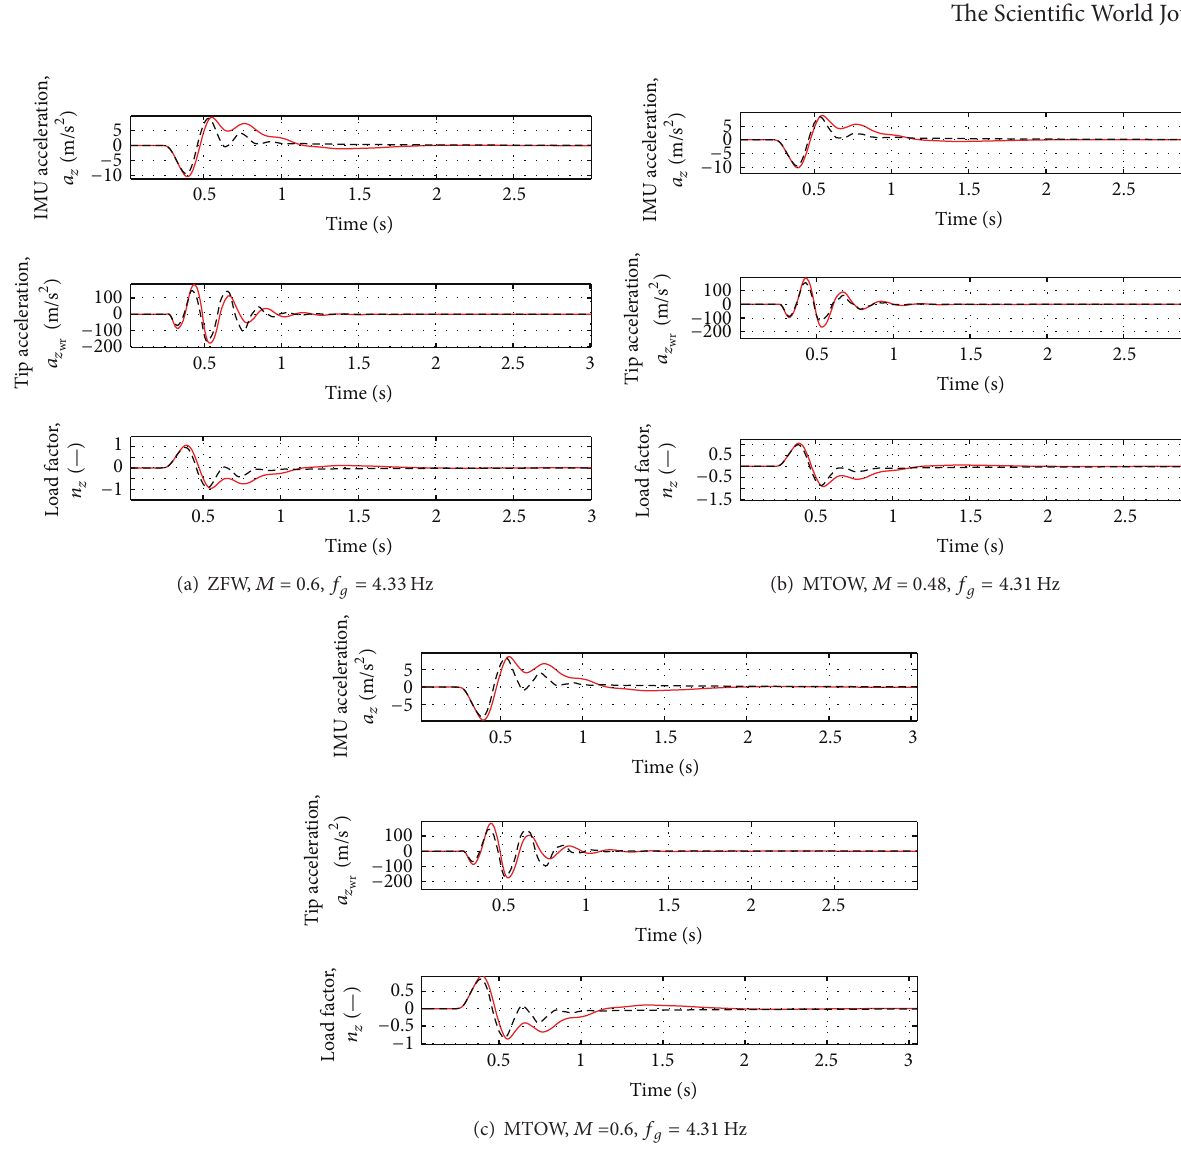
(i) input command saturation and computational delay, (ii) rate saturation and output surface position saturation (implemented inside the control